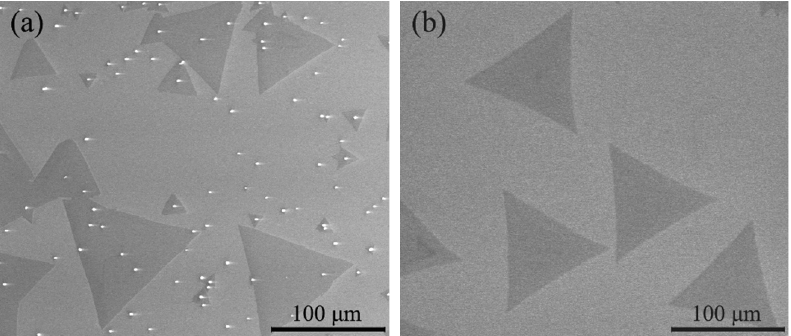
Figure 3. Scanning electron microscope (SEM) images of MoS 2 prepared by using the two heating methods: ( a ) one-step heating and ( b ) two-step heating.